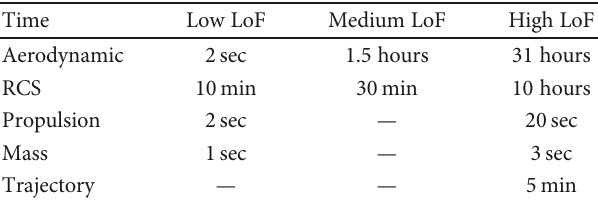
Table 5: Computational time of each discipline codes. Table 6: Accuracy of each discipline codes.